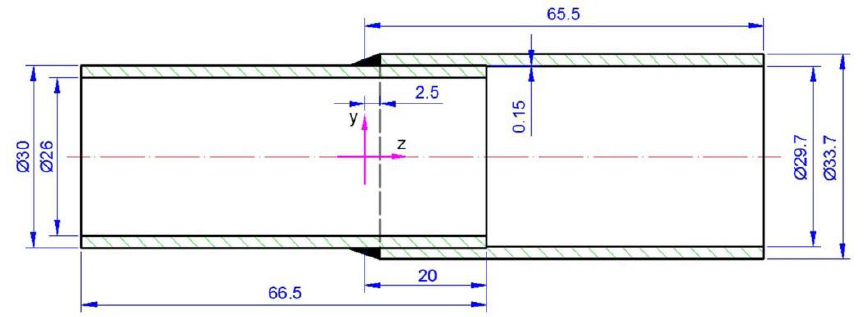
Figure 1. Diagram of the analyzed system.